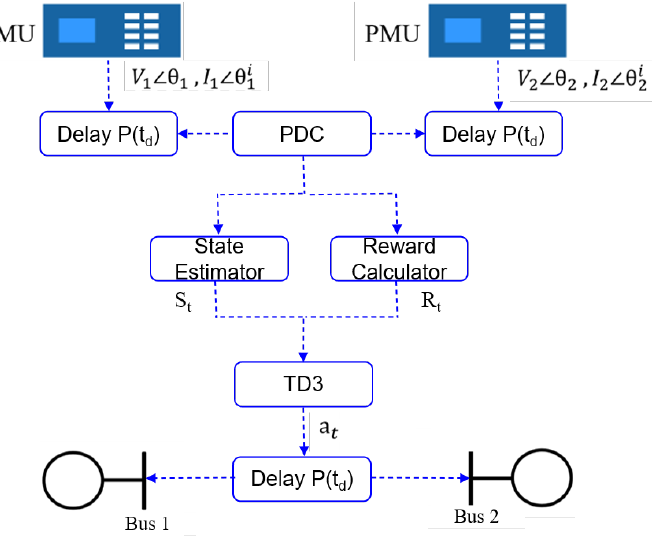
Figure 2. Framework of the overall scheme. The communication links are exhibited by blue dot- ted